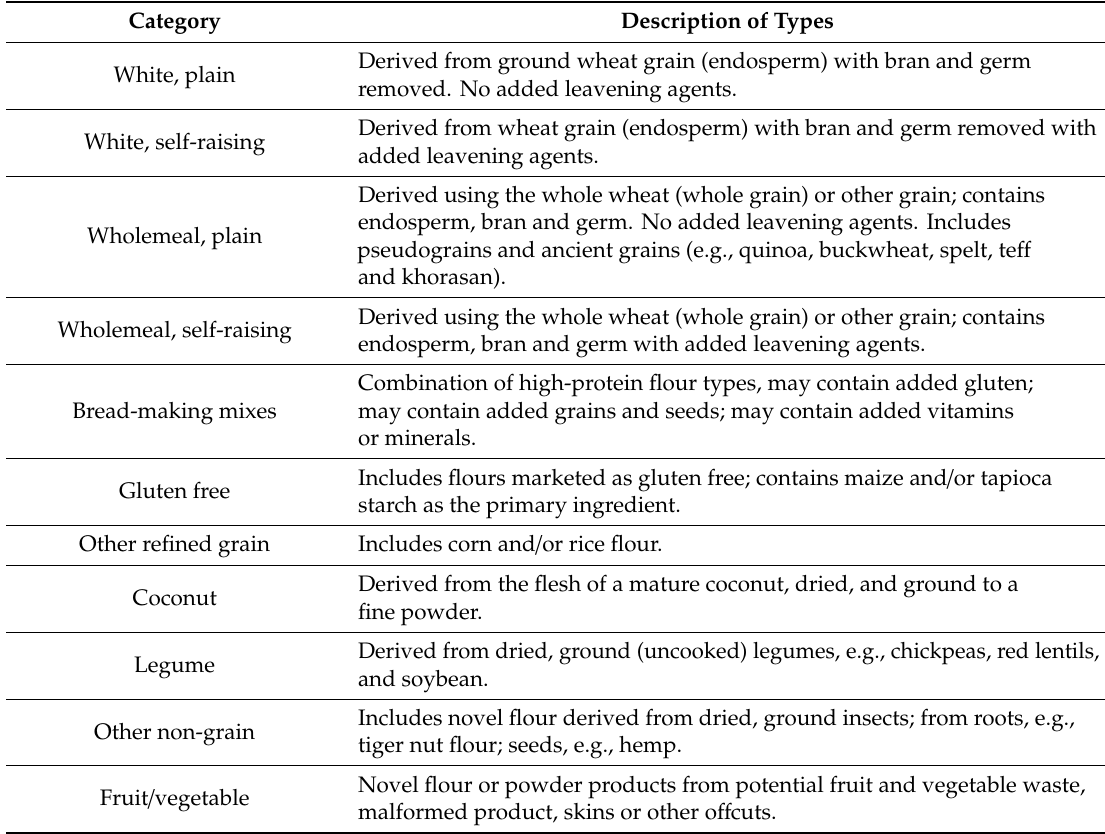
Table 1. Classification of flour